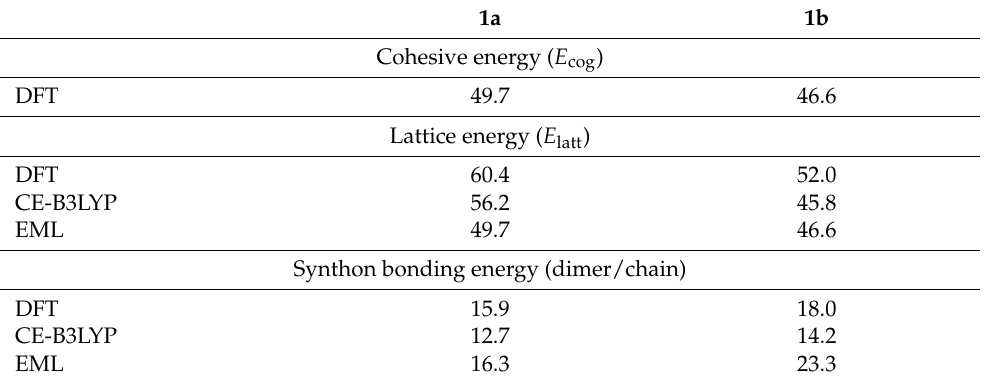
Table 4. Energetic characteristics (kcal/mol) of crystal structures and supramolecular synthons of 1 calculated with different methods: DFT stands for PBE0-D3/POB-TZVP-rev2 ab initio calculations; CE-B3LYP is semi-empirical approach implemented in CrystaExplorer program; EML is the Espinosa– Molins–Lecomte